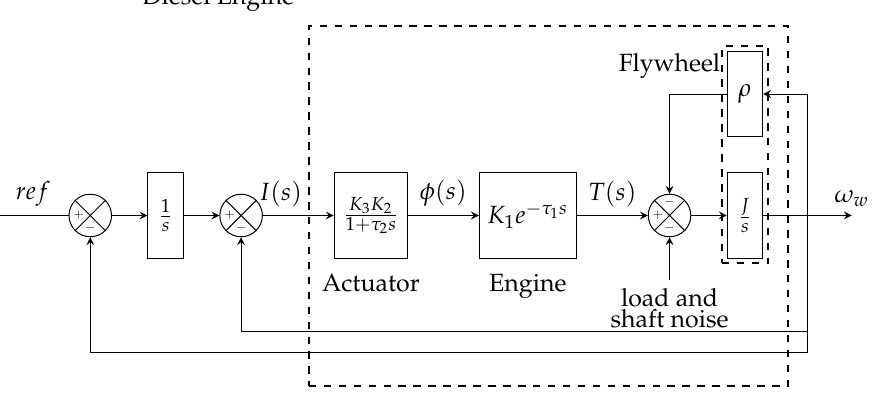
Figure 3. Block diagram of the diesel engine system.